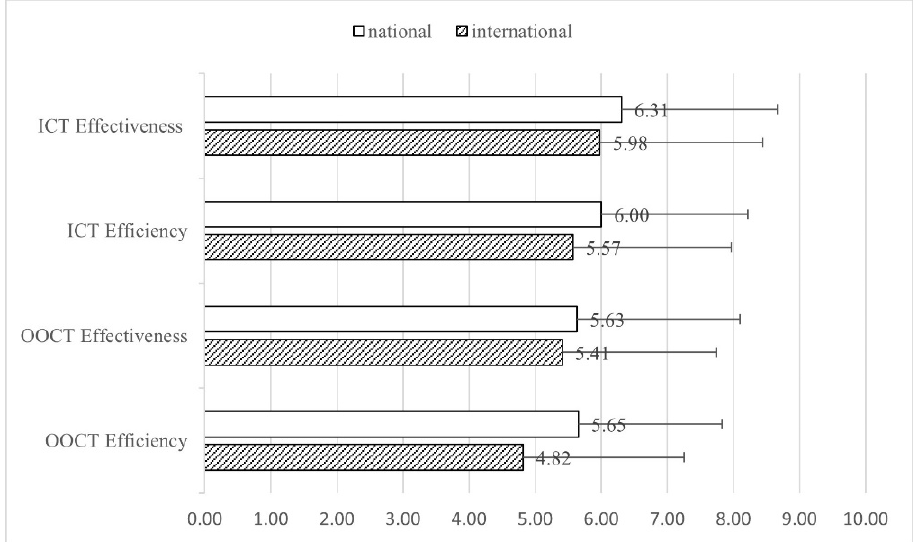
Figure 2. Trust in and satisfaction with organizations. Note: WADA = World Anti-Doping Agency, NADA = National Anti-Doping Agency, IOC = International Olympic Committee, ÖOC = Austrian Olympic Committee.